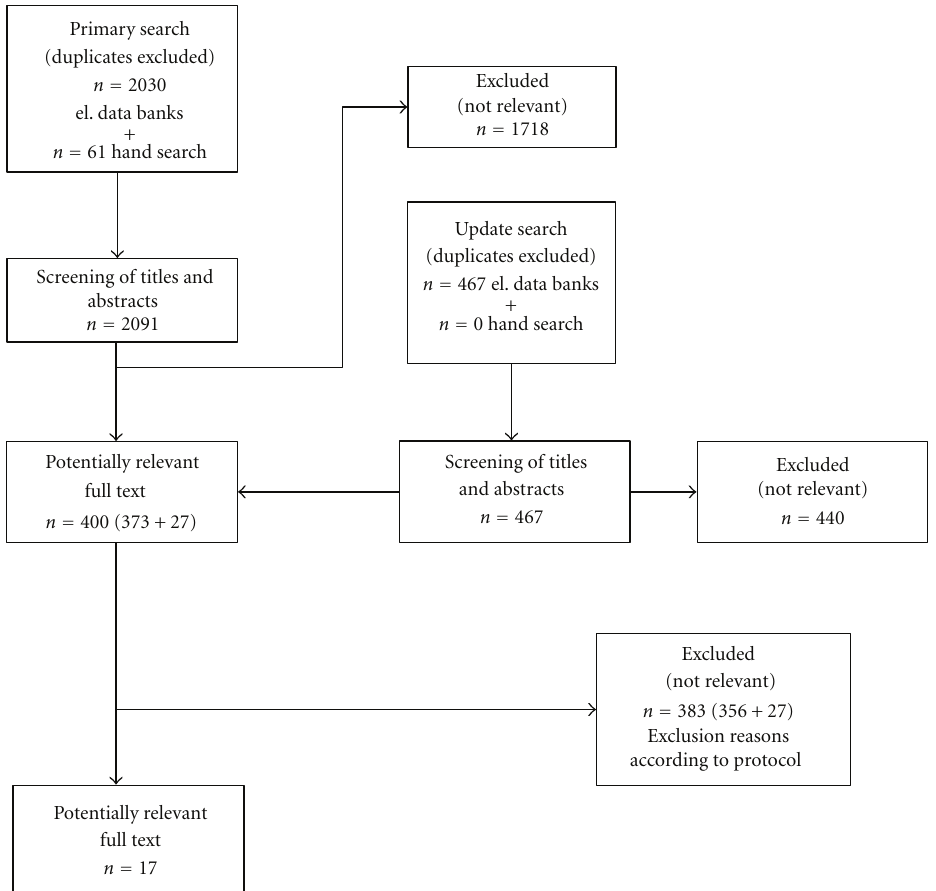
Figure 1: Flow chart literature